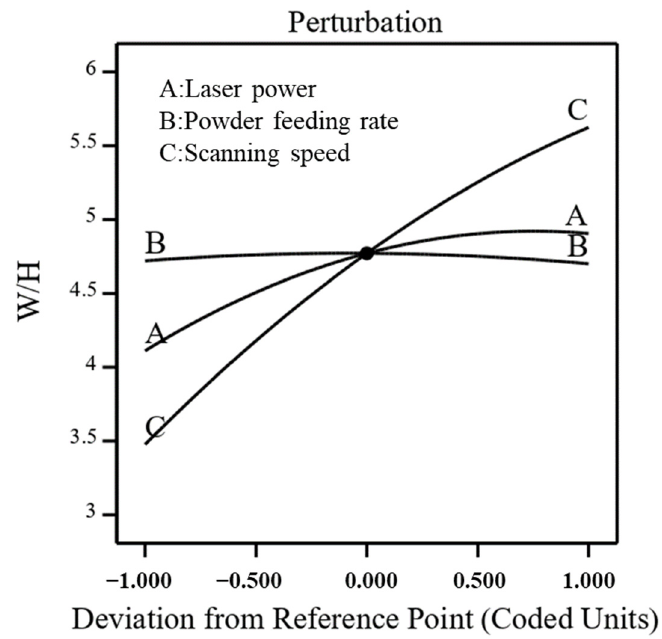
Figure 7. Perturbation of three process parameters to the W/H.